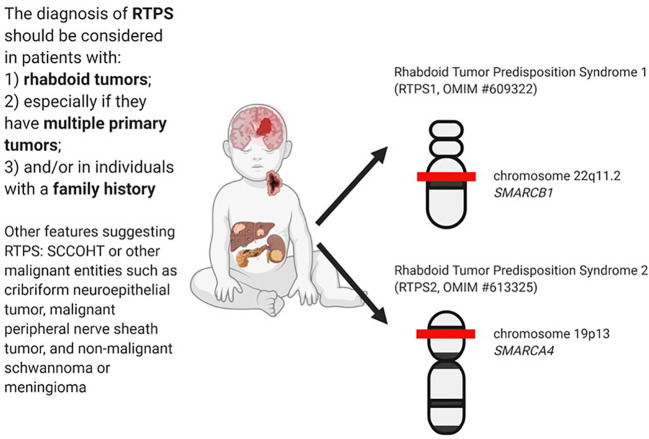
RTPS tumors spectrum and related genes involved.